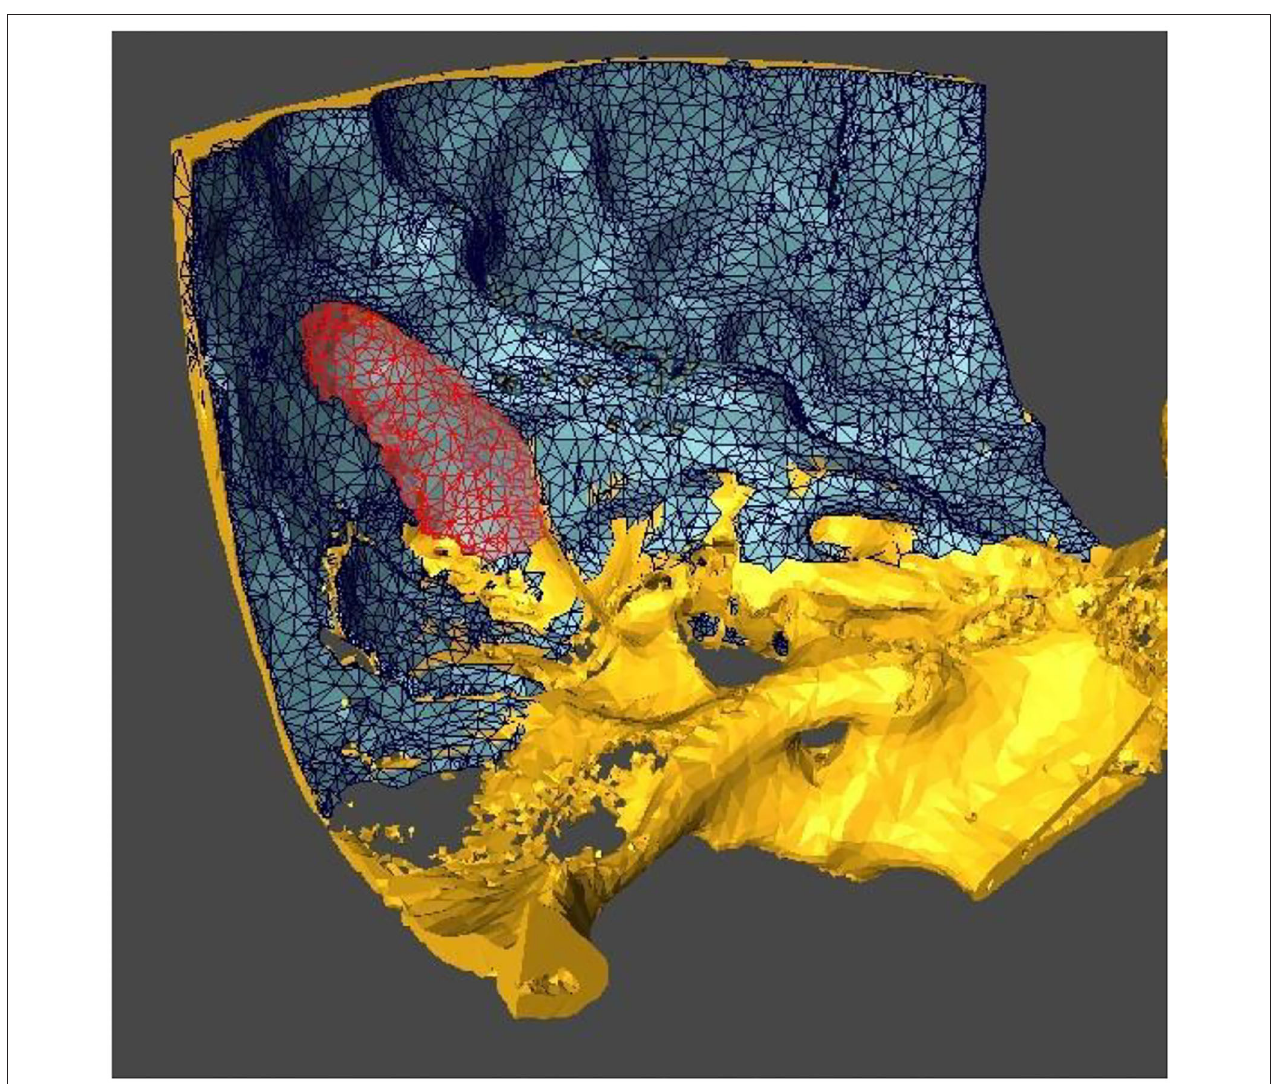
FIGURE 1 | Segmented temporal bone (yellow), dura (blue and black lines) and sigmoid sinus (red). (temporal line superiorly tangent to external auditory canal and postero-inferior rim of the canal) and parallel to the temporal line and superior and posterior to the spine of Henle ( Figure 2 ).